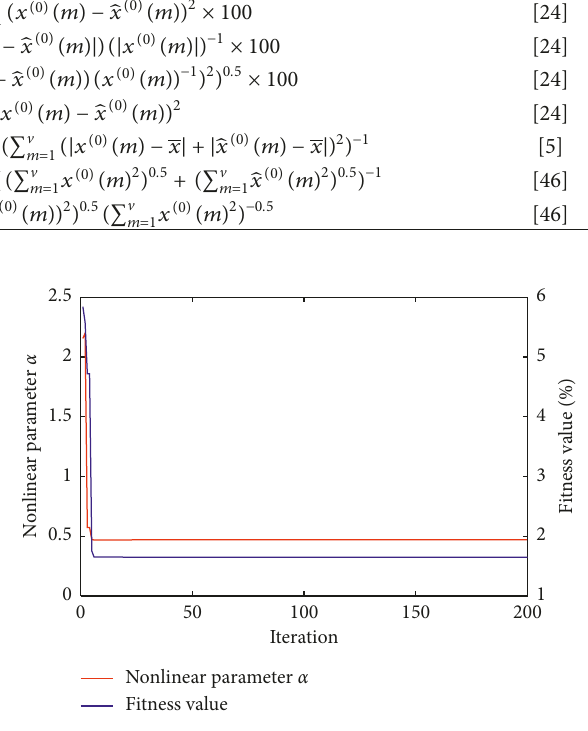
Figure 2: Convergence curve of WOA in Example